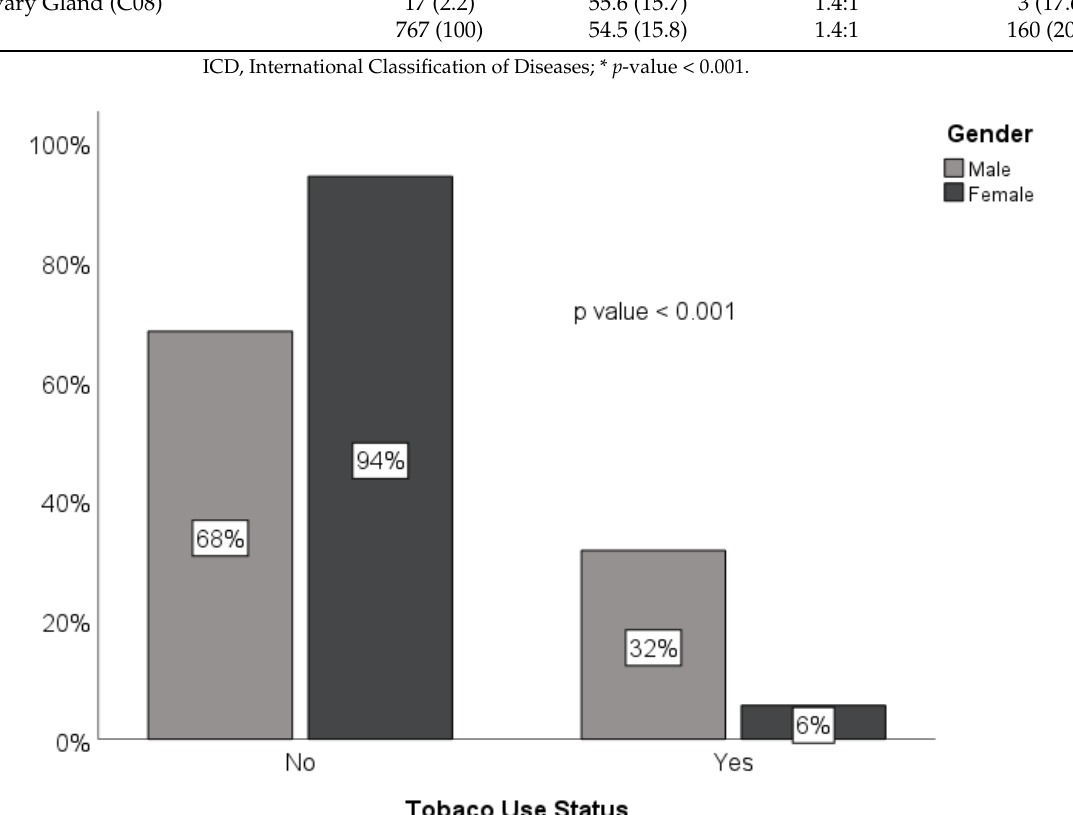
Figure 4. Distribution of tobacco use status by gender. Table 1. Characteristics of study participants, n = 767.